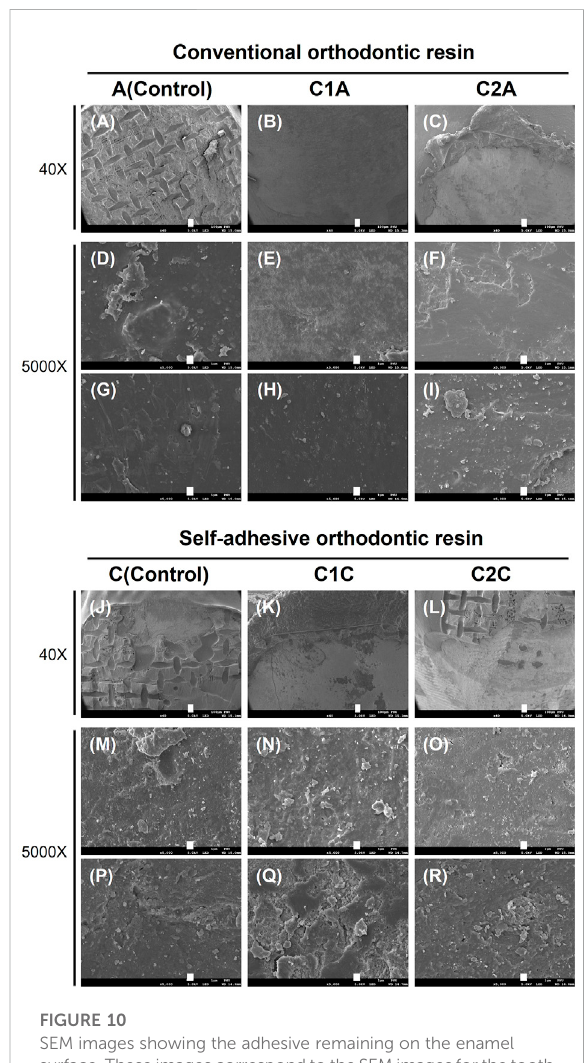
FIGURE 10 SEM images showing the adhesive remaining on the enamel surface.TheseimagescorrespondtotheSEMimagesforthetooth specimens shown in Figure 9. Each row represents a different magni fi cation (40× and 5,000×, respectively). Each scale bar represents 100 and 1 µm, in that order. (A,D,G) , 35% H 3 PO 4 + conventional orthodontic resin; (B,E,H) , CPICs-incorporated H 3 PO 4 solution-I + conventional orthodontic resin; (C,F,I) , CPICs- incorporated H 3 PO 4 solution-II + conventional orthodontic resin; (J,M,P) , 35% H 3 PO 4 + self-adhesive orthodontic resin; (K,N,Q) , CPICs-incorporatedH 3 PO 4